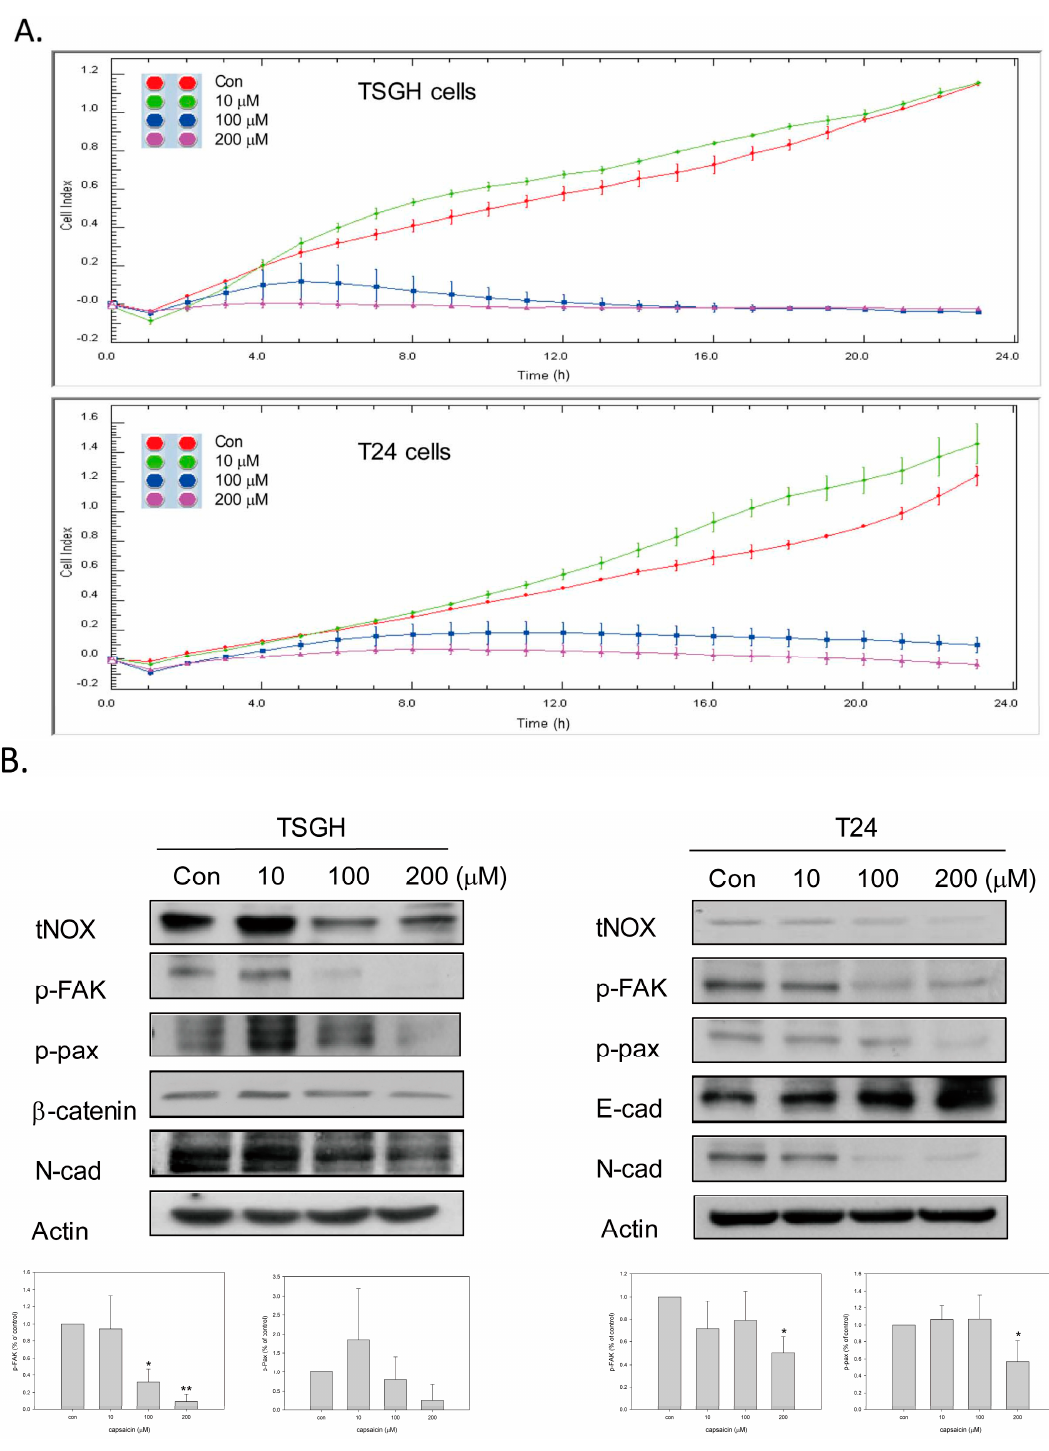
Figure 4. Capsaicin attenuates cell migration. ( A ) Dynamic monitoring of cell migration using impedance technology, as described in Materials and Methods. Shown are normalized cell index measured over 23 h; ( B ) Cells were treated with capsaicin or ethanol for 18 h. Aliquots of cell lysates were separated by SDS-PAGE and analyzed by western blotting. β -actin was used as an internal control. The intensity of a protein band was quantified by Gel-Pro Analyzer software 3.1. The resultant values of protein expression were normalized to those of actin. Values (mean SE) are from three independent experiments (* p < 0.05, ** p < 0.01).